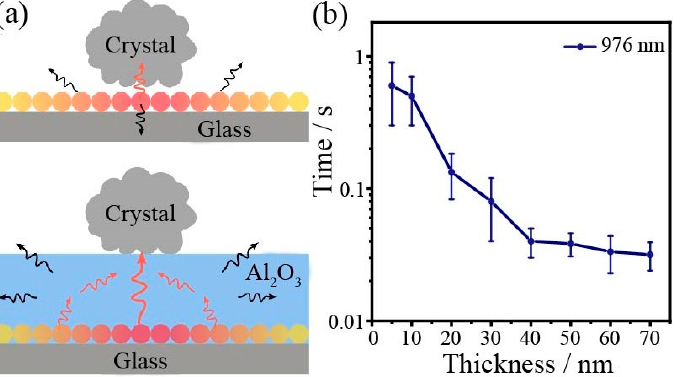
Figure 6. ( a ) Schematic diagram of heat transfer in the system with and without the Al 2 O 3 heat trapping layer. ( b ) Crystal irradiation time for Al NIs as a function of Al 2 O 3 thickness, from 5 to 70